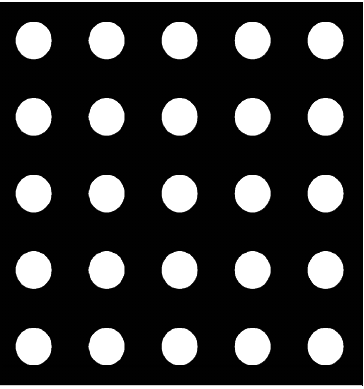
Figure 4. Porous material with periodically distributed and non-interacting pores.